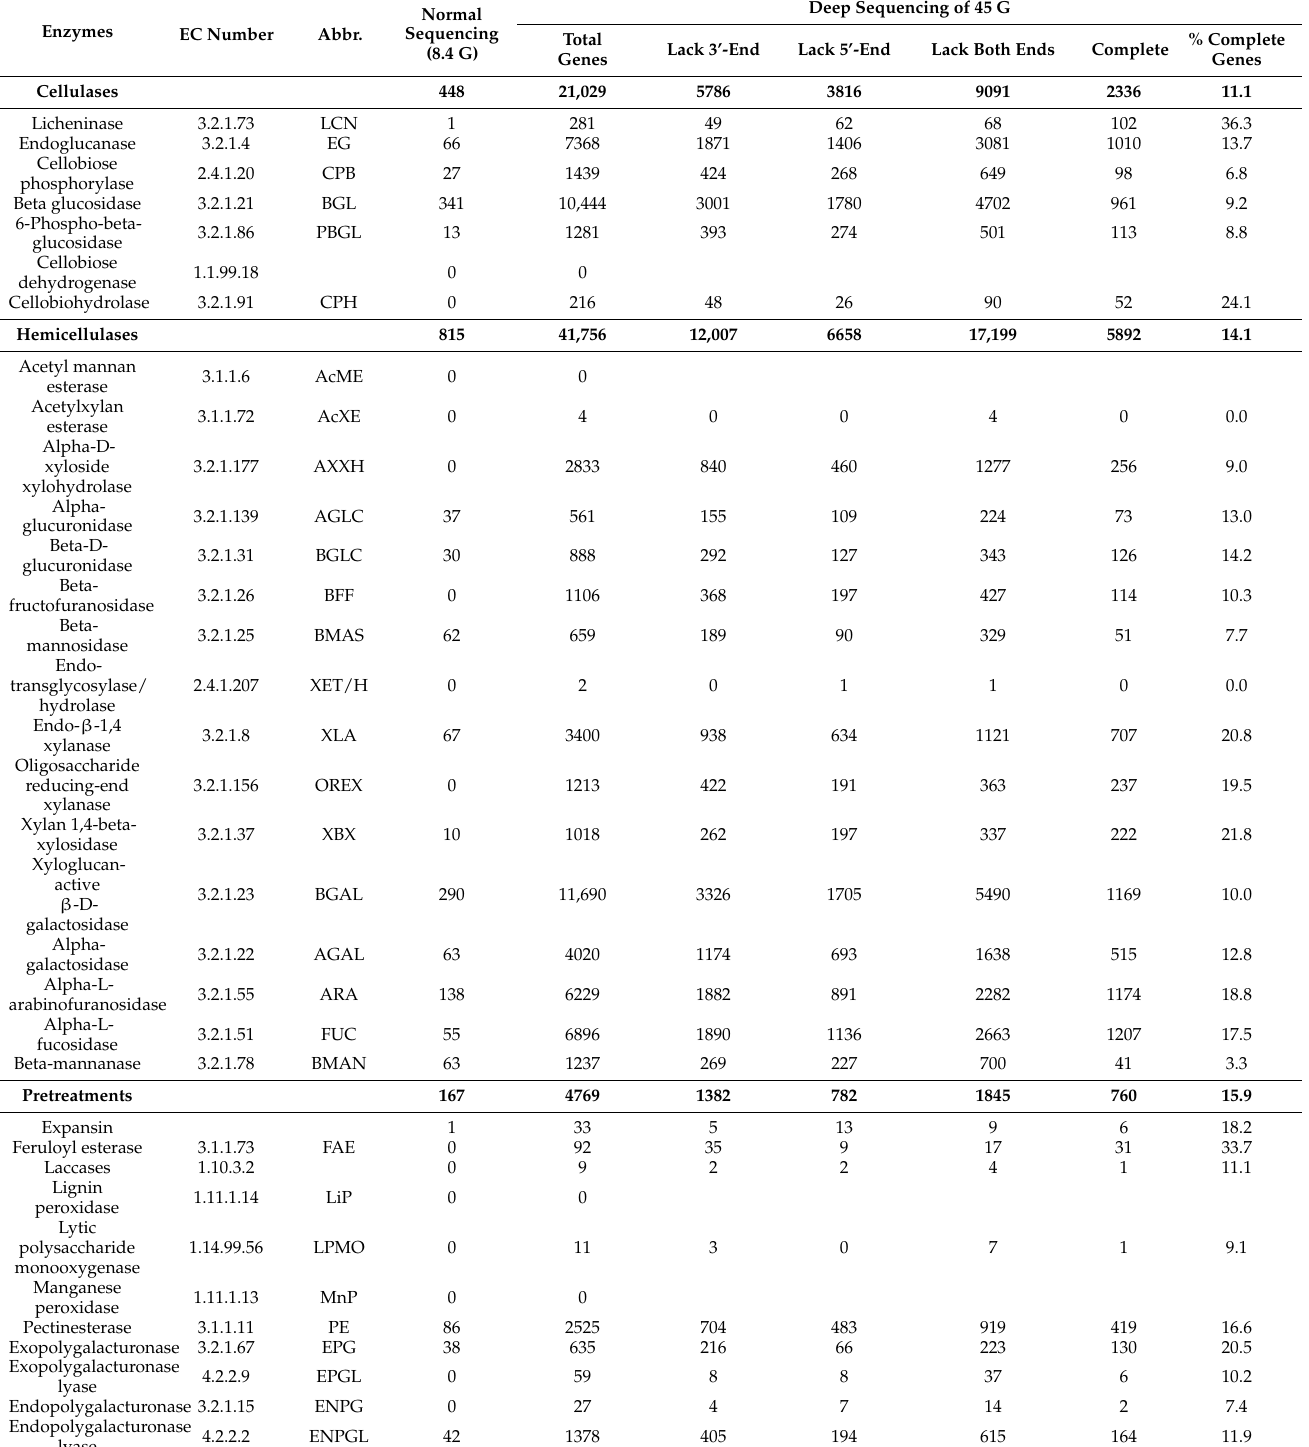
Table 1. List of proteins/enzymes related to lignocellulose conversion that mined from metagenomic deep sequencing data and compared to metagenomic normal sequencing data [11] of bacteria in Vietnamese goats’